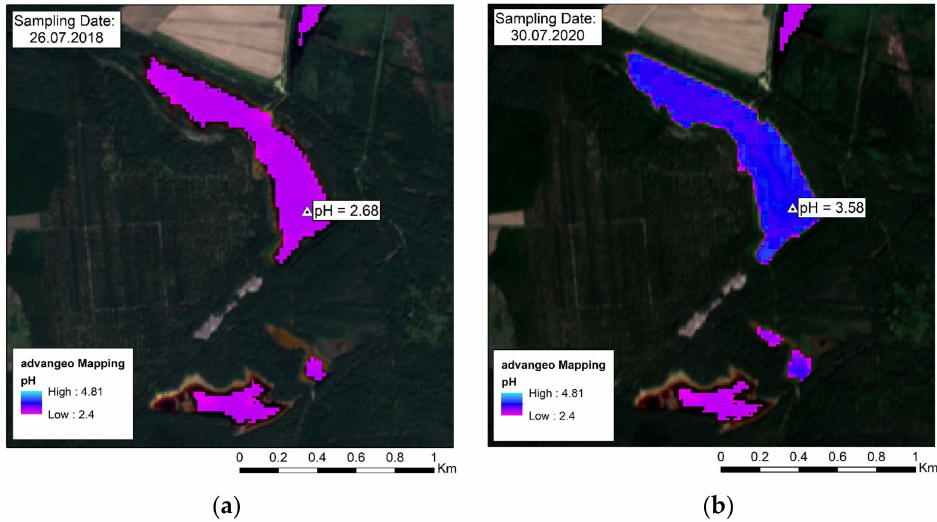
Figure 24. Distribution map of pH values in the “Grüner See” ( a ) in July 2018 with AMD and ( b ) in July 2020 after the neutralization of the acid mine